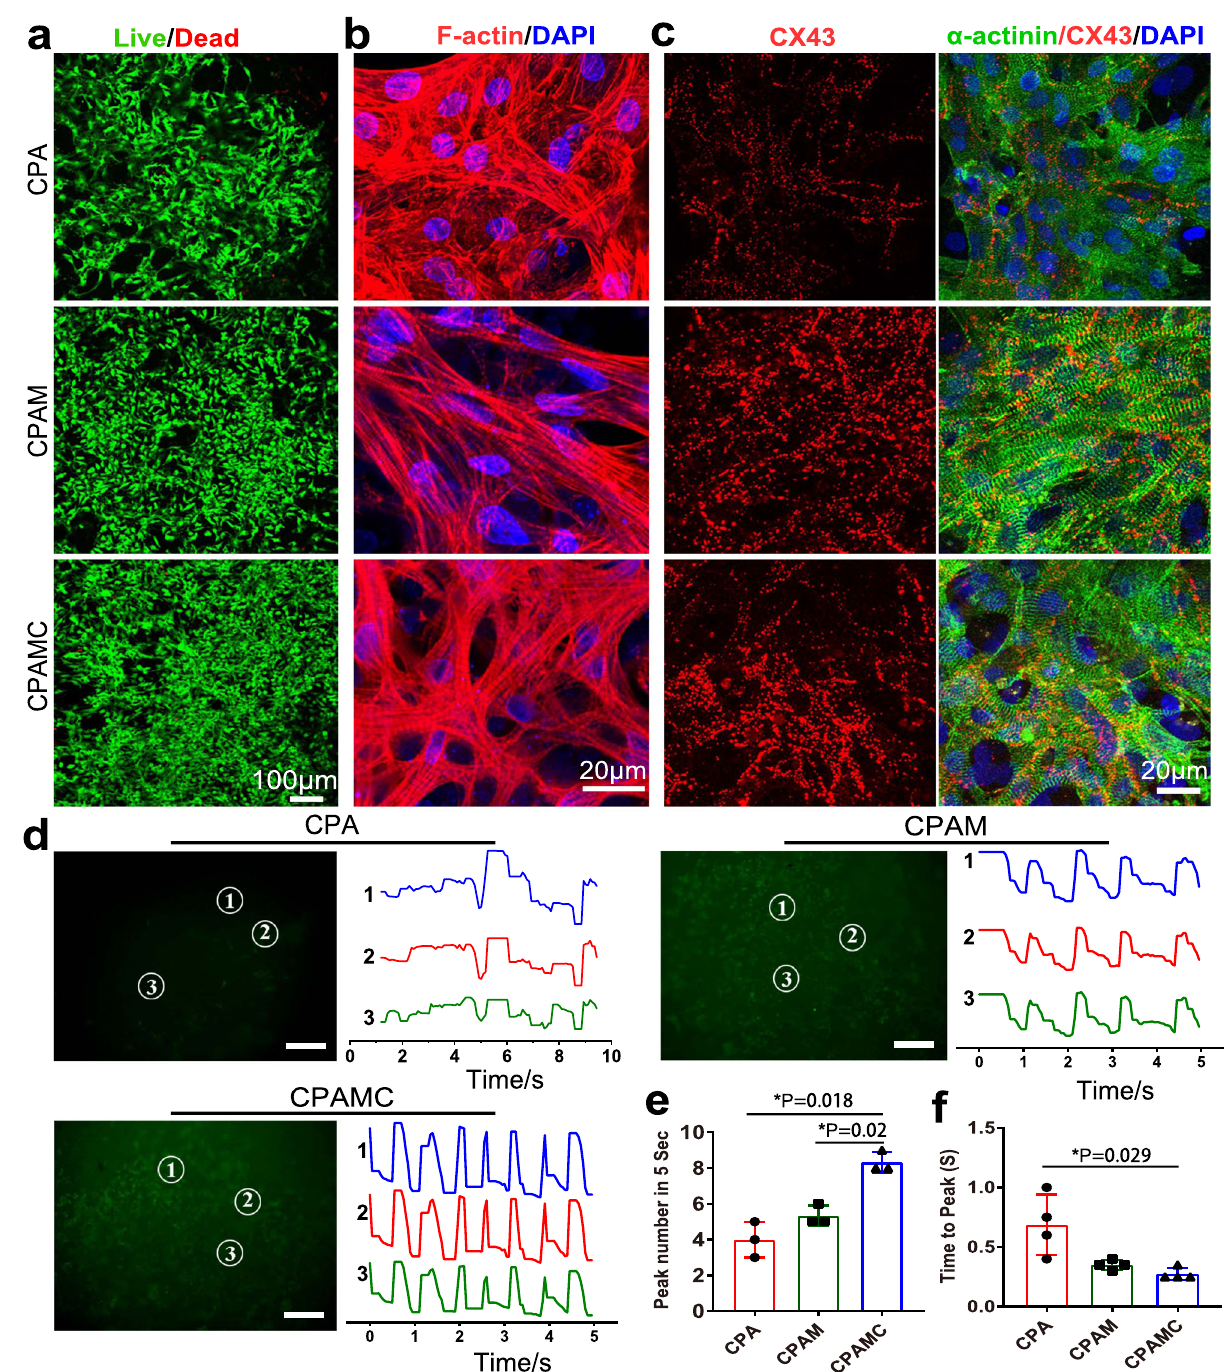
p value was generated by one ‐ way analysis of variance (ANOVA), followed by Tukey ’ s multiple ‐ comparison post hoc test, n =3 independent samples). f Ca 2+ transientpropagationtimetopeakindifferenthydrogelsbasedontheimageof( d ) (error bar means the standard deviation, * p <0.05, ** p <0.01, *** p <0.001, p value was generated by one ‐ way analysis of variance (ANOVA), followed by Tukey ’ s multiple ‐ comparison post hoc test, n =4 independent samples). CAP, CPAM, CPAMC: C, aldehyde cellulose (CNC-CHO); P, polyethylenimine (PEI); A, acrylic acid; M, 3-sulfonic acid propyl methyl acrylic acid potassium (MASEP); C, caffeic acid (CA).